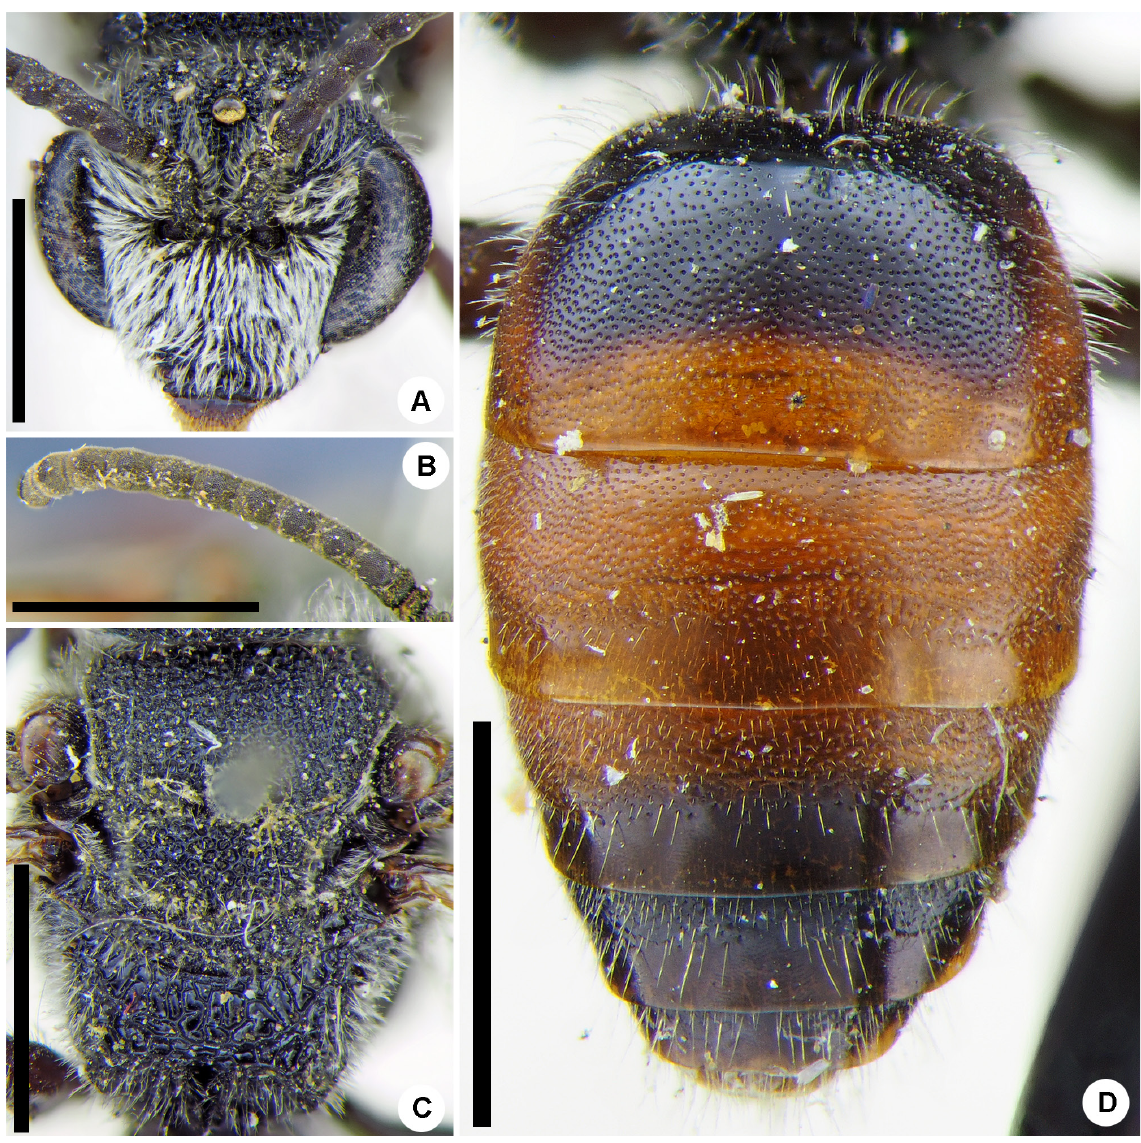
Fig. 10. Sphecodes invidus (Cameron, 1897) (holotype of S. nigrobasalis Meyer, 1922), ♂ (ZMHB). A . Head in frontal view. B . Antenna in lateral view. C . Mesosoma in dorsal view. D . Metasoma in dorsal view. Scale bars = 1.0